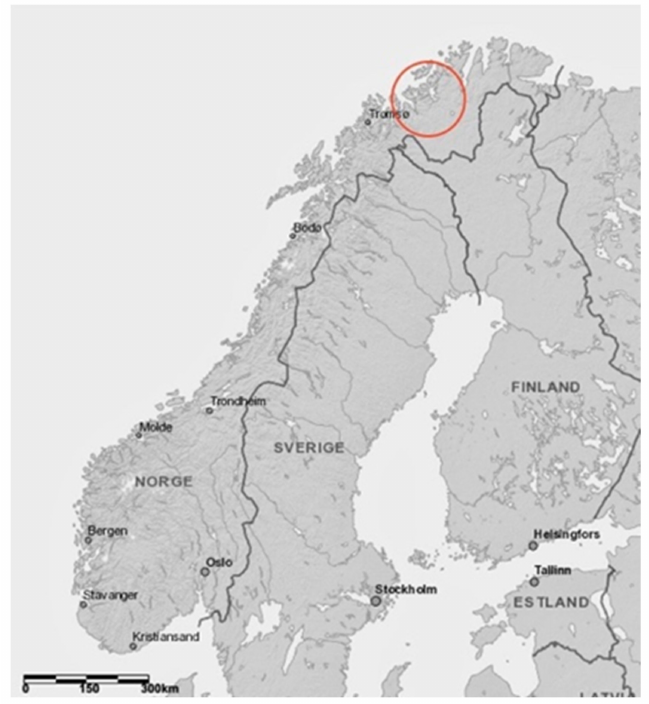
Figure 3. Study area in Northern